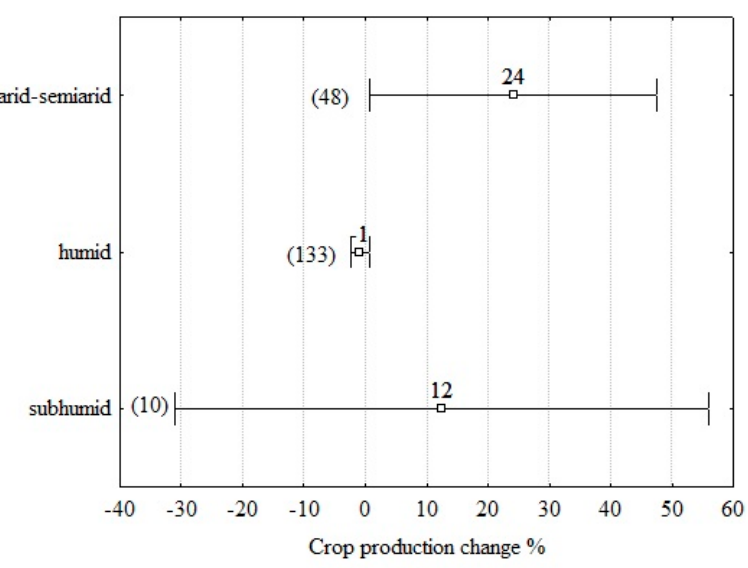
Figure 3. Mean plot of crop production change (%) in conservation tillage vs. conventional deep tillage grouped by aridity class [15]. Box—Whisker plots represent central point means, and 95% confidence interval. Numbers in brackets represent the number of comparisons used in each category.